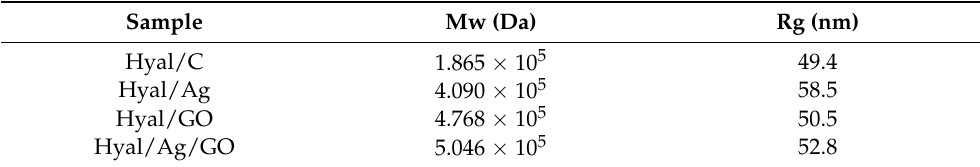
Table 1. The average molecular weight (Mw) and radius of gyration (Rg) of Hyal/C, Hyal/Ag, Hyal/GO, and Hy-al/Ag/GO.